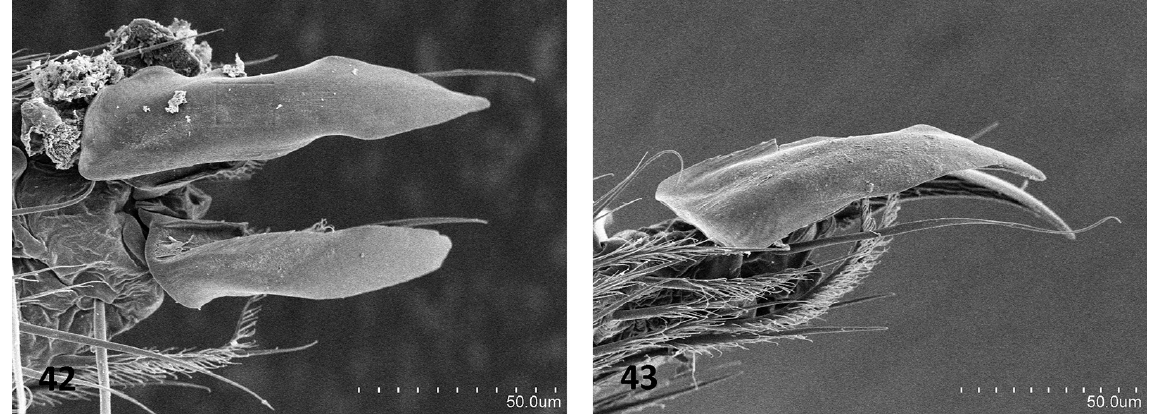
Figs 42–43. Plusiocampa ( Plusiocampa ) bulgarica Silvestri, 1931, from Sbrikovata Cave, Pamporovo, Bulgaria (Coll. AS). 42 . Pretarsus, dorsal view. 43 . Pretarsus, latero-posterior